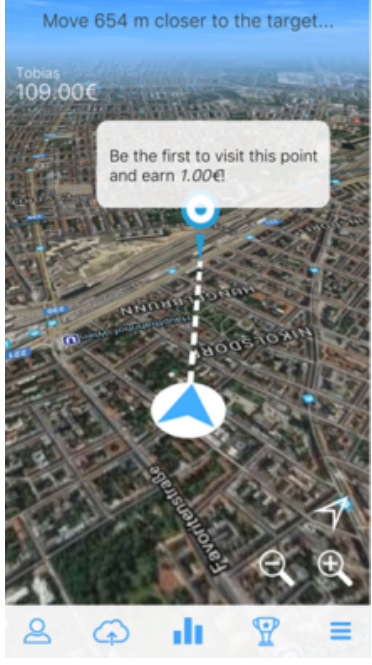
Figure 6. An image from the FotoQuest-Go mobile app.